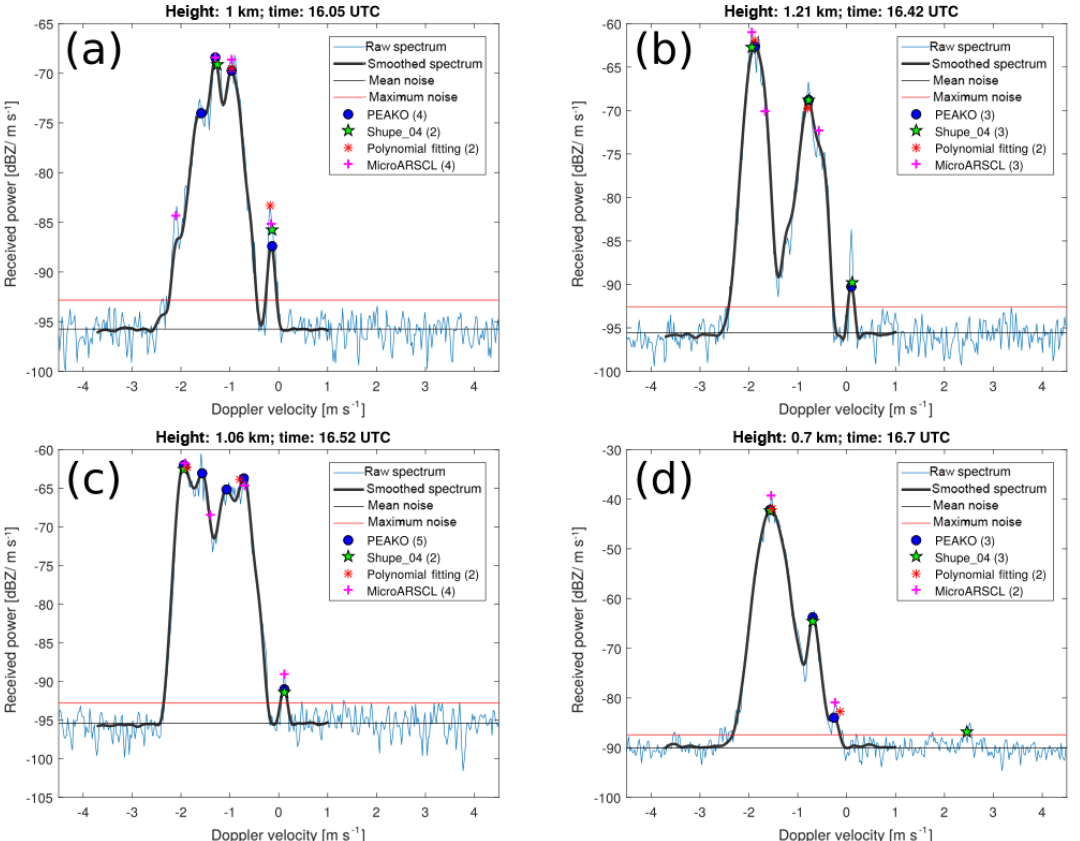
Figure 12. Four exemplary Doppler spectra picked from the case study on 2 February 2014, 16:00 to 17:00UTC, at 0 to 2.5km altitude. The averaged and smoothed spectrum which is used as input to PEAKO is drawn in bold over the original spectrum. The peaks detected by the four algorithms are marked. The number of peaks found by each algorithm is noted in parentheses in each figure legend. Mean and maximum noise floors are presented by black and red horizontal lines, respectively. Please note that the scale of the y axis is different in each